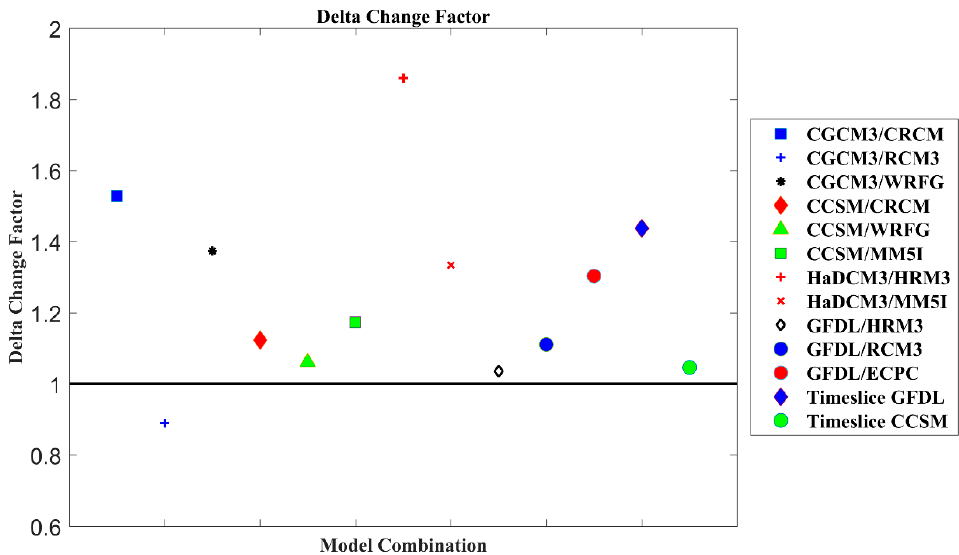
Figure 3. Delta change factor for all the NARCAAP datasets. The horizontal line represents the “no changes in future” climate scenario (DCF = 1).